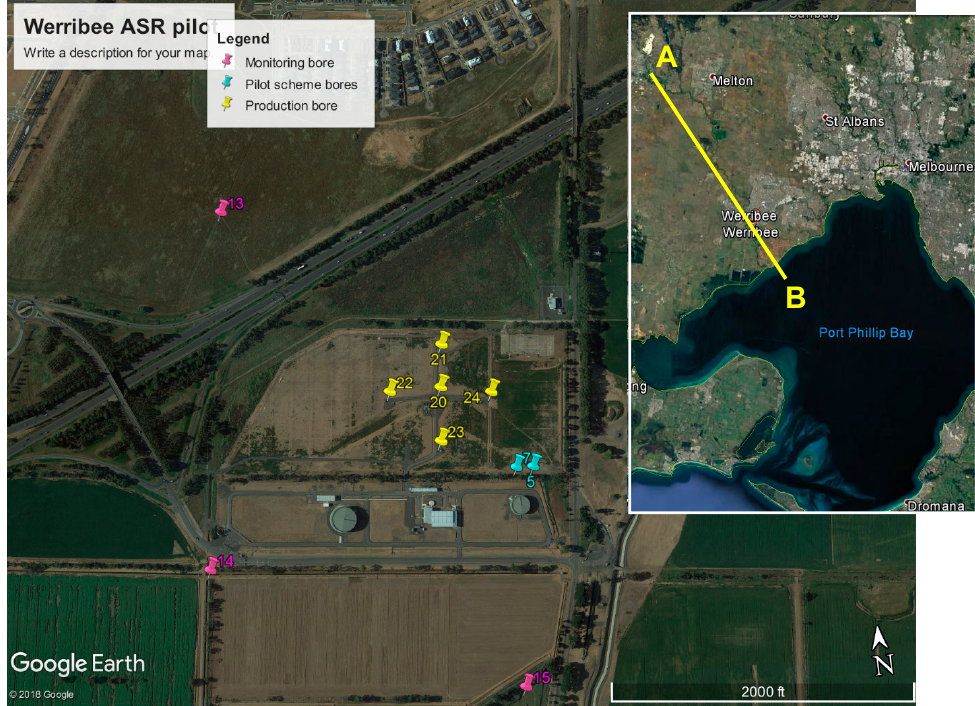
Figure 1. Site map showing the location of the aquifer storage recovery (ASR) (production) and monitoring wells. ASR well 5 was the production well during the trial in 2012, with its monitoring well 7 at ca. 40 m distance. Production wells 20–24 form together the future West Werribee ASR plant, but for now they are part of the second pilot, with well 20 as ASR well and 21–24 as monitoring wells. AB = geological section shown in Figure 2.